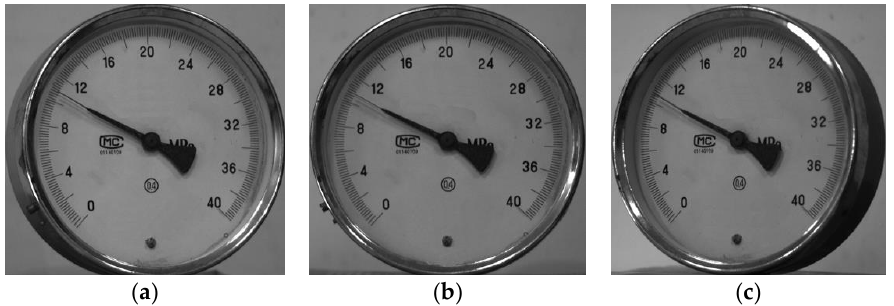
Figure A3. The meter image taken by camera from three angles when the reading of the pointer meter is 10.7; ( a ) the camera at position 1; ( b ) the camera at position 2; ( c ) the camera at position 3.